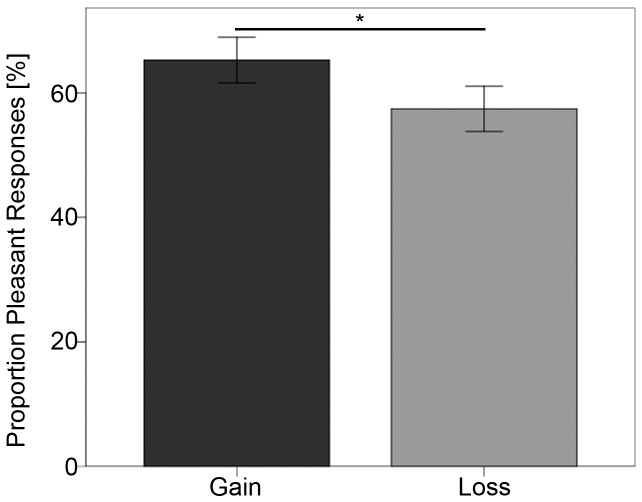
Implicit Affect Measure.Proportion of “pleasant” responses as a function of outcome. Error bars represent one standard error. *Indicates significant difference between conditions at p<0.05.